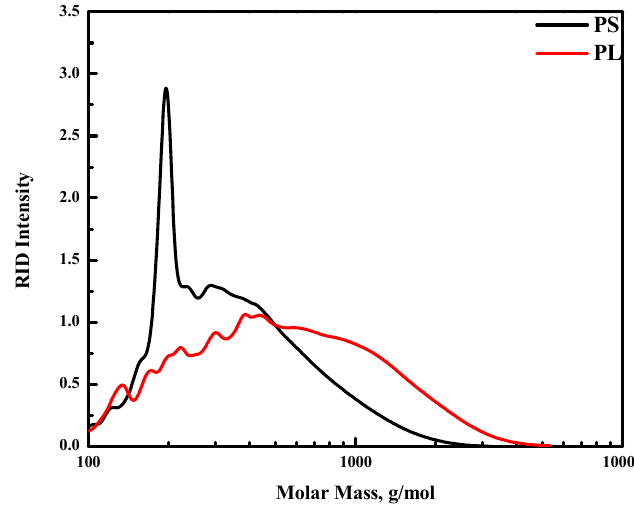
Figure 1. Molecular weight distributions of the initial PS, PL feeds by GPC.